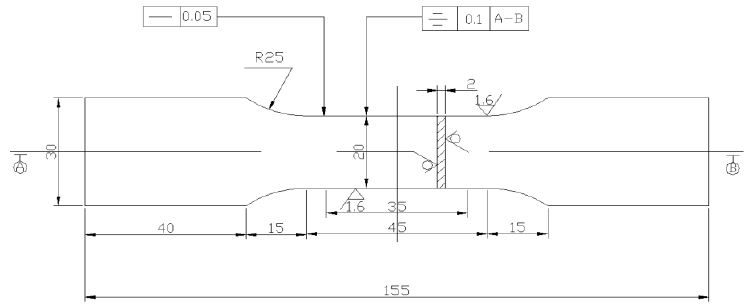
Figure 3. The shape and size of stretched specimen.